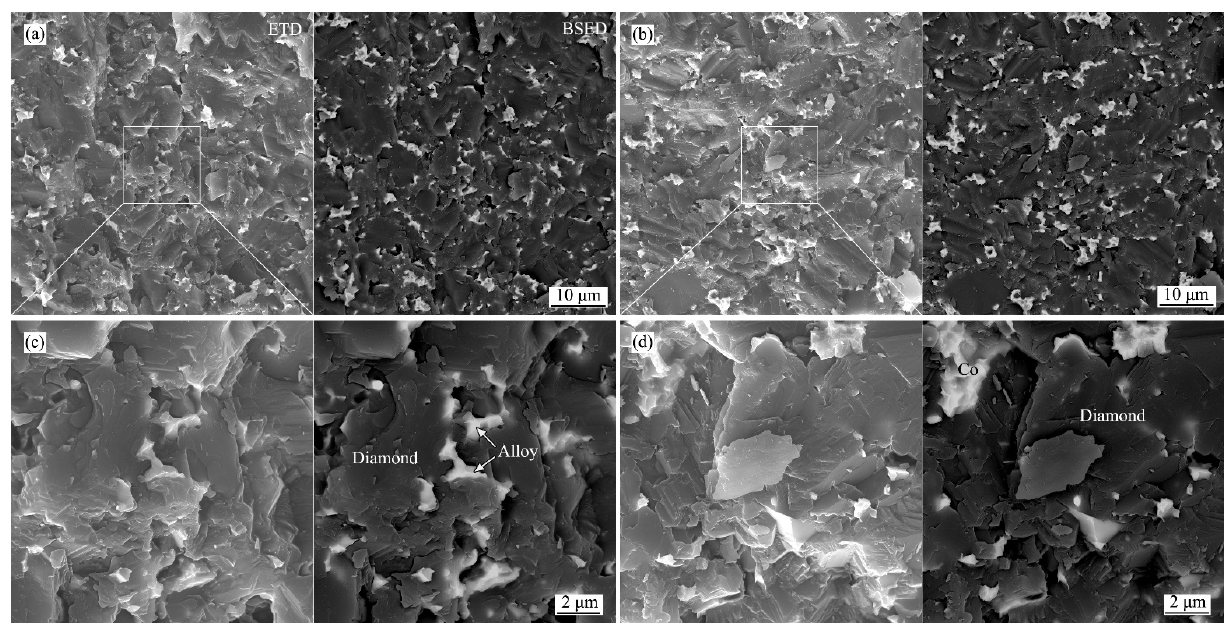
Figure 8. Secondary electron images (EDT, left half) and backscattered electron images (BSED, right half) of fracture morphologies of Co 50 Ni 40 Fe 10 -PCD ( a , c ) and Co-PCD ( b , d ).